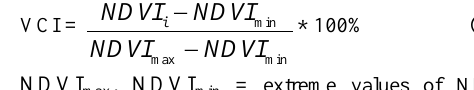
Figure 1. Areas with low values of VCI which referred to the oblast area, Kostanay, 2012 According to satellite data the area of plots in the Kostanai region with VCI<0.1, referred to the area of the region, (very severe drought) exceeded the 50% threshold in the 2nd decade of